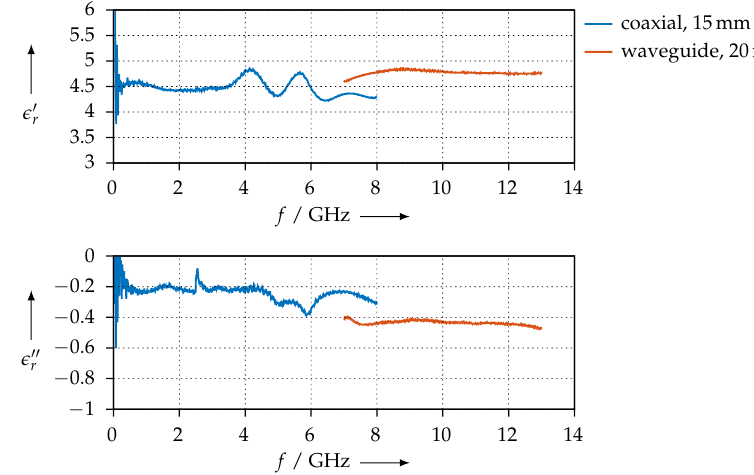
Figure 24. Real ( (cid:101) (cid:48) r ) and imaginary ( (cid:101) (cid:48)(cid:48) r ) parts of the permittivity for the SAAB material.